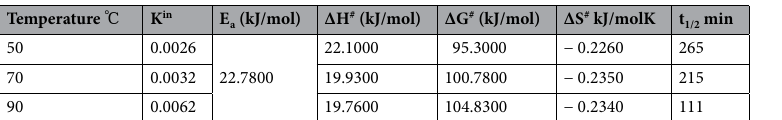
Table 1. Thermodynamic parameters for irreversible thermal inactivation of